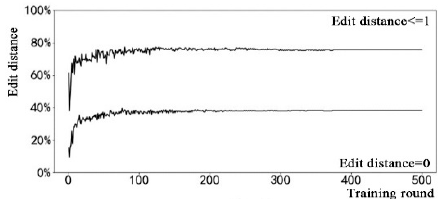
Figure 22. Expert-driven learning with a factor of 1/3.